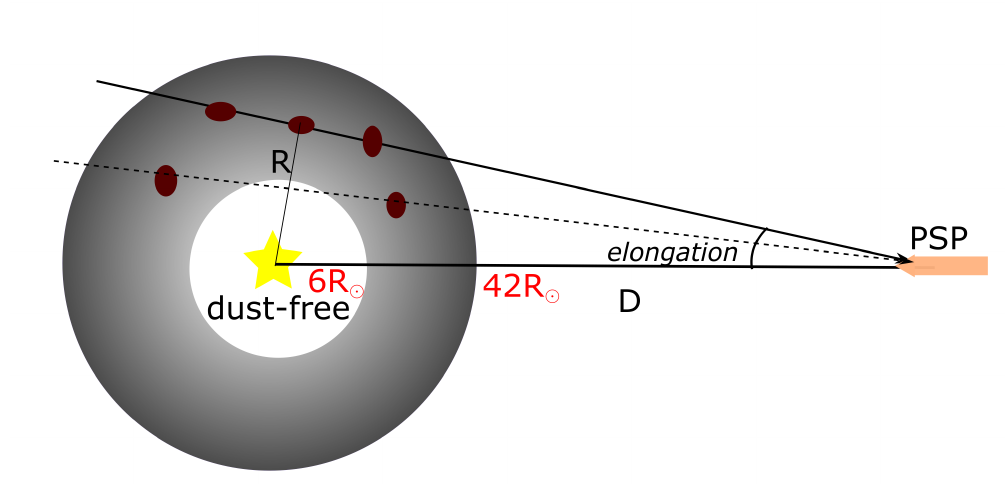
Figure 28. Schematic illustration of the F-corona predicted by RATD and nonthermal sputtering which would be observed by the Parker Solar Probe (PSP) at heliocentric distance of D = 0.3 AU and various elongation angles. The F-corona decrease is illustrated by a radial gradient, starting from 42 R edge of the new dust-free-zone at 6 R (cid:12)